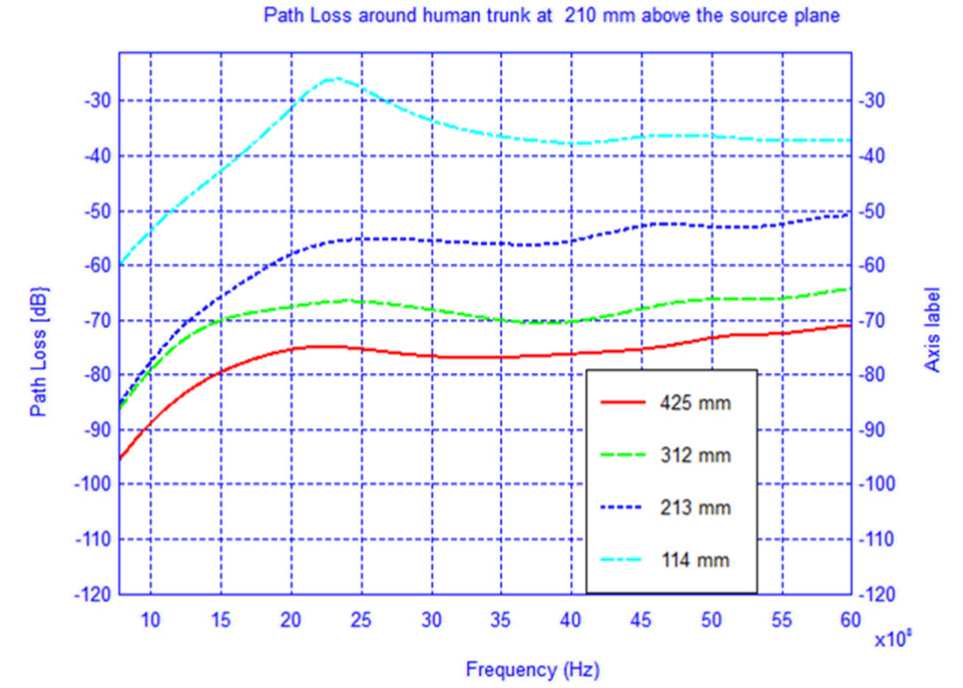
Figure 3. Path loss around the cylindrical human trunk model 210 mm above source plane.